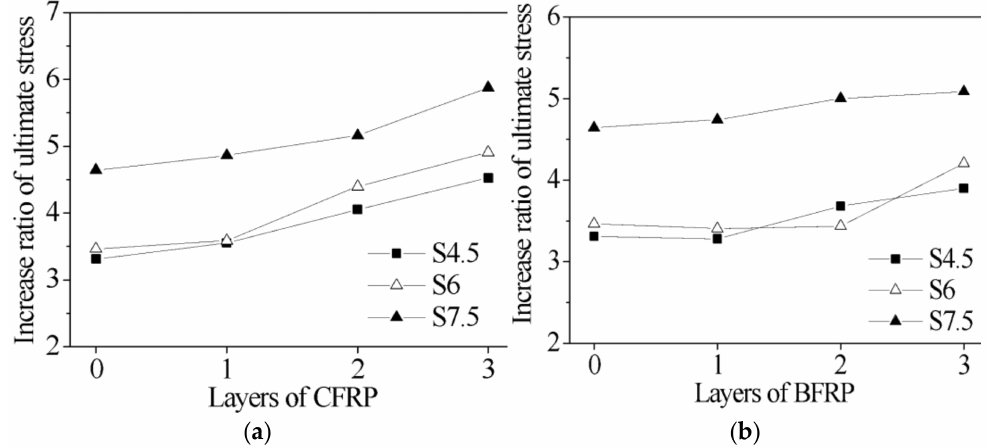
Figure 9. Effect of the number of layers of FRP on the ultimate stress. ( a ) Specimens wrapped with CFRP. ( b ) T Specimens wrapped with